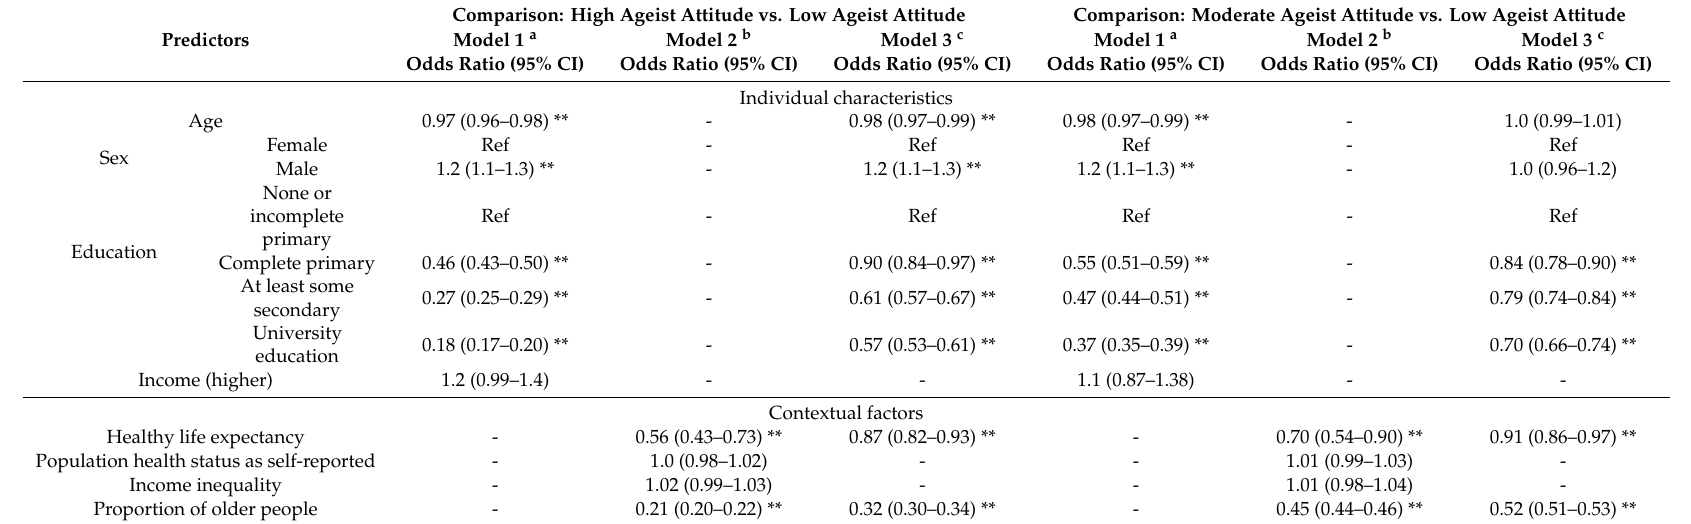
Table 1. Multinomial logistic regression results: influence of individual characteristics and contextual factors on Level 1 latent class membership. Comparison: High Ageist Attitude vs. Low Ageist Predictors